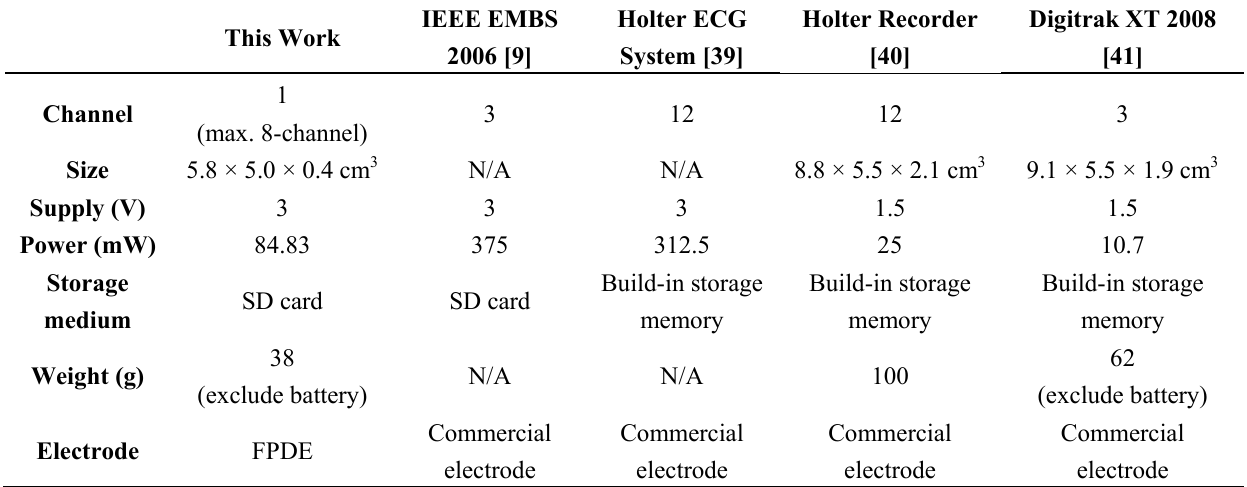
Table 4. Comparison between our system and other recent similar works.